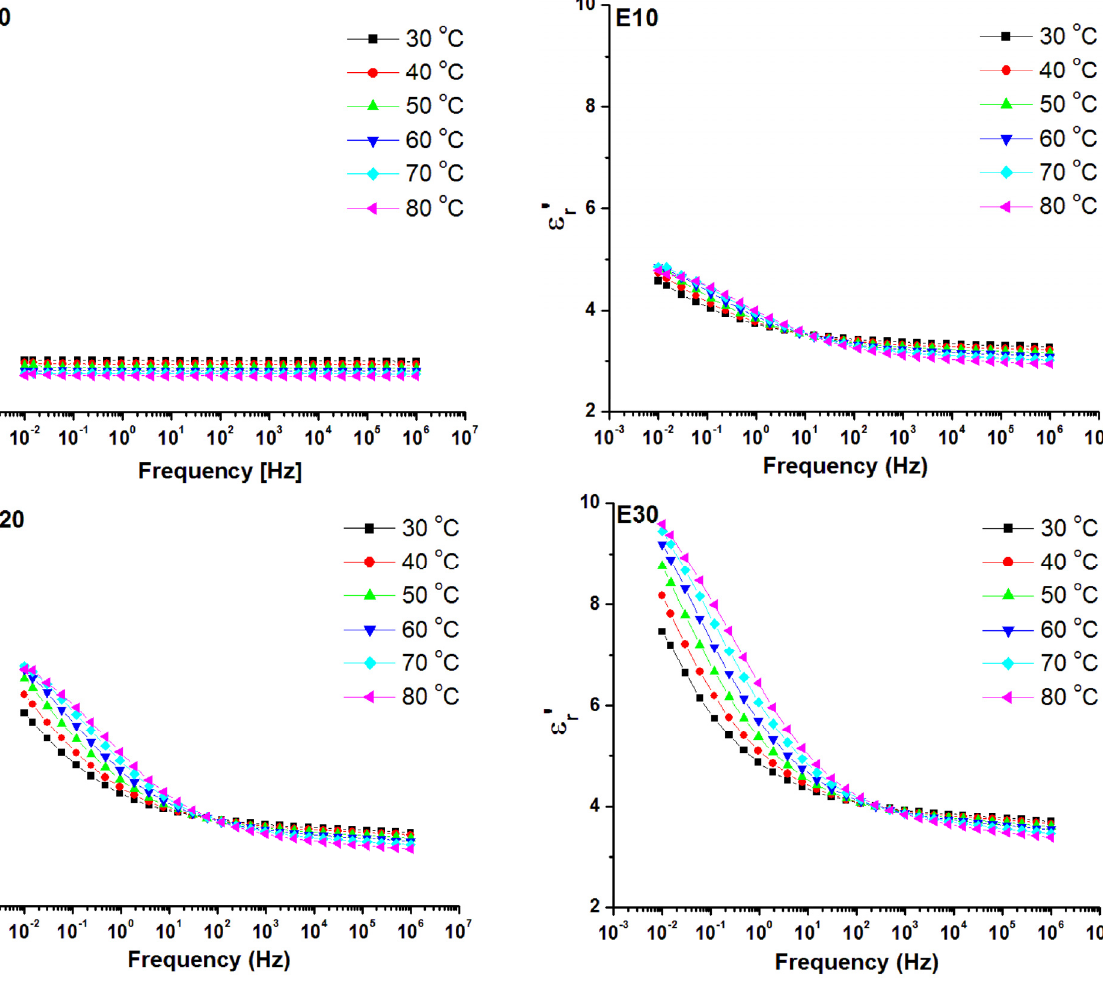
Figure 11. Dependence of ε r ’ versus frequency for temperatures in the range 30–80 °C for unmodified polysiloxane (E0) and nanocomposites (E10, E20 and E30).